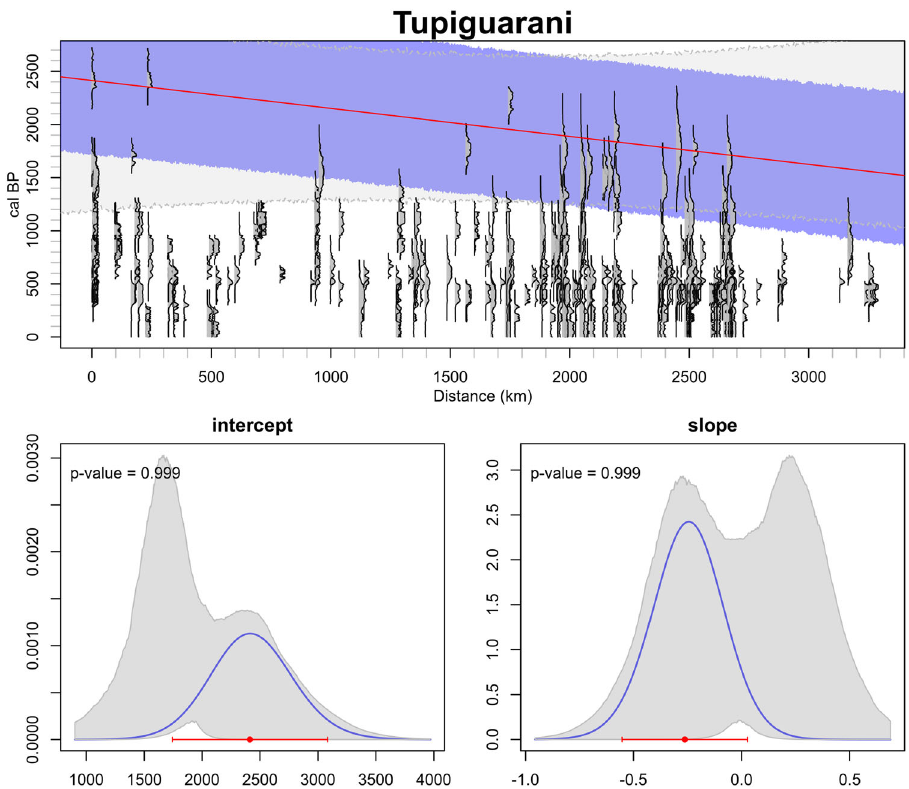
Fig. 4 Results of the radiometric regression analysis on the Tupiguarani dataset. Top: Bivariate plot of age versus distance from chosen origin, showing the calibrated radiometric densities (grey curves), the result of the quantile regression to 99th-percentile when using median dates (red line), the spread of regressed lines when taking the full radiometric uncertainty into account (blue-shaded region), and the con fi dence envelope of the null hypothesis of no- dispersal (grey-shaded region with dashed border). Bottom Left: Summed probability density of obtained y -intercept regression parameter for the empirical dataset (blue curve), con fi dence envelope of the null hypothesis of nodispersal (grey-shaded region), best estimate and corresponding 95% range when doing regression with median dates (red dot and bar). Bottom Right: Summed probability density of obtained slope regression parameter with the same key as the previous panel.